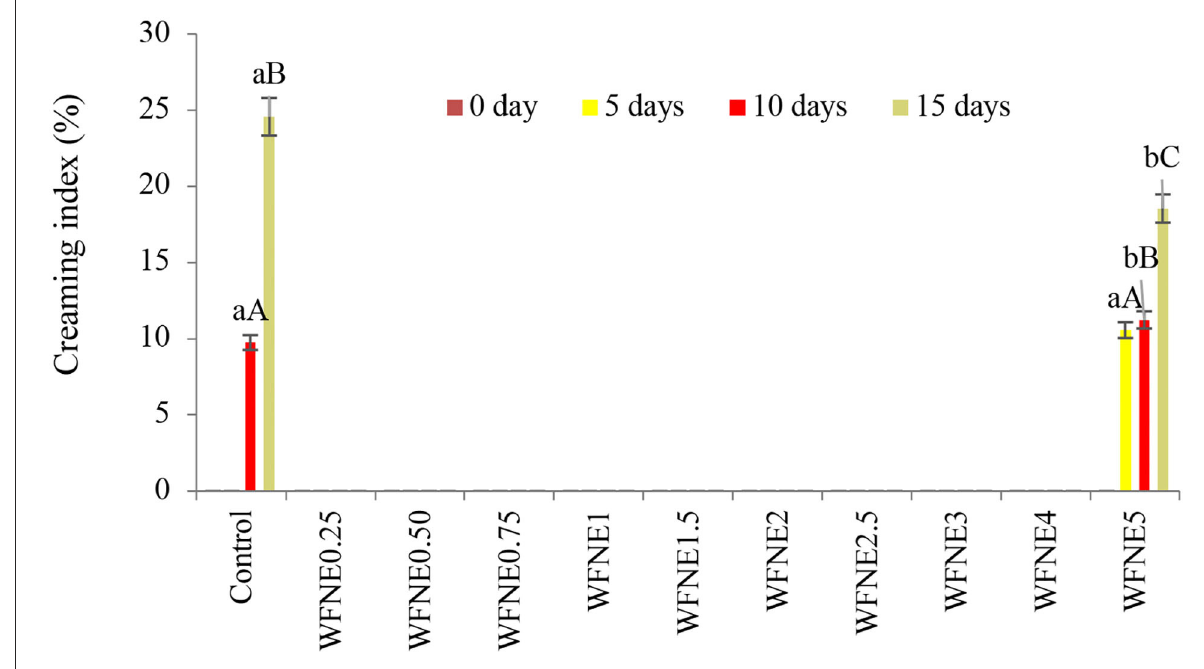
FIGURE2 Creaming index of WFNE3 nanoemulsion. The error bar represents the standard deviation from the mean